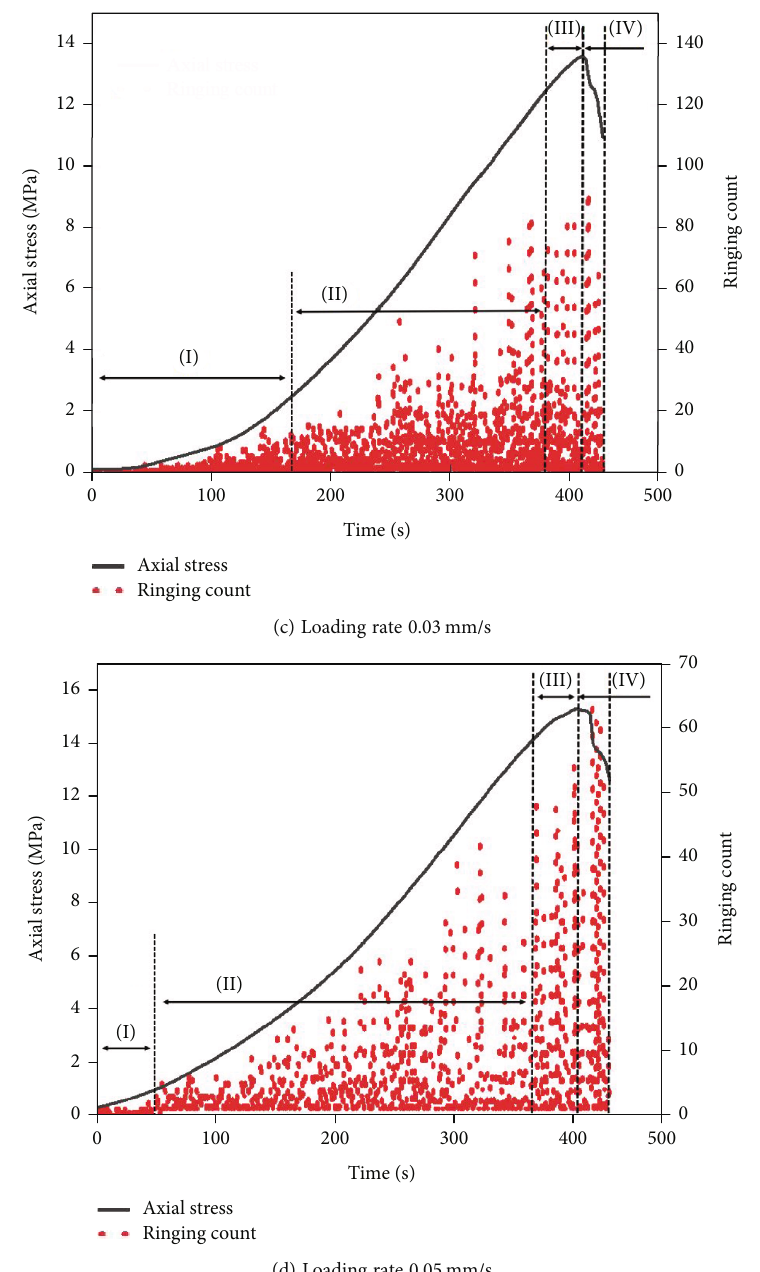
Figure 12: Stress and ring count curves with time during uniaxial compression of specimens with the fi ssure inclination angle of 30 ° under di ff erent loading